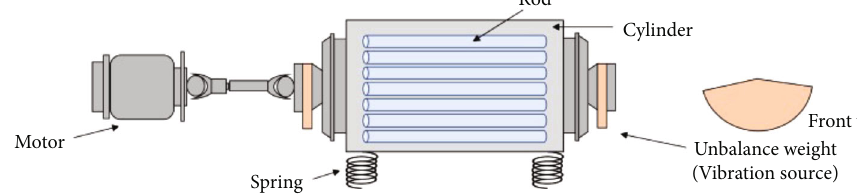
Figure 6: Rod mill [14].